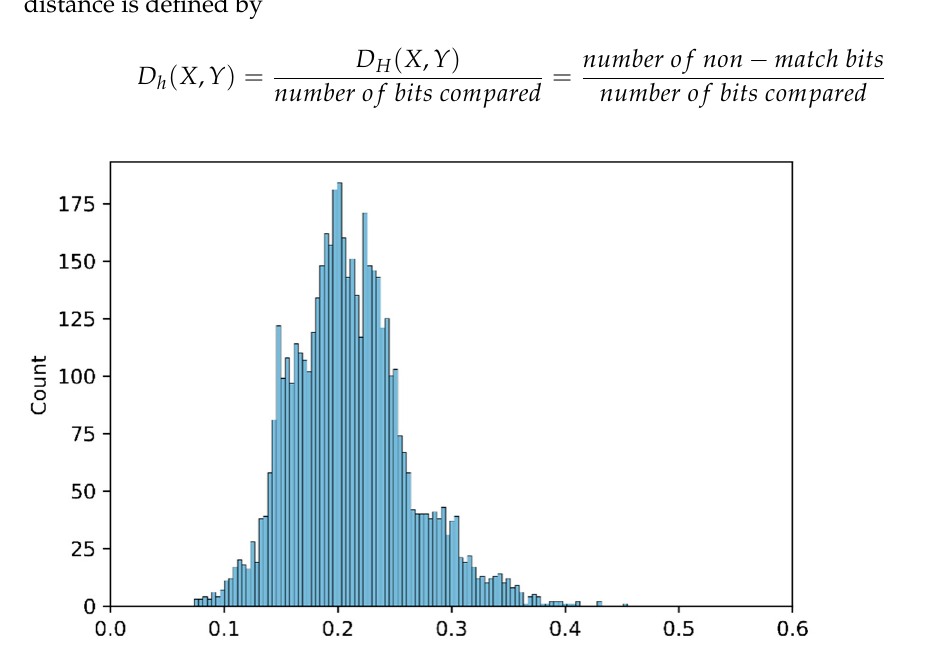
Figure 6. Histogram of normalized Hamming distances of all 4950 pairs of uttered words. Mean and dispersion of normalized Hamming distances (0.2111 ± 0.0511).